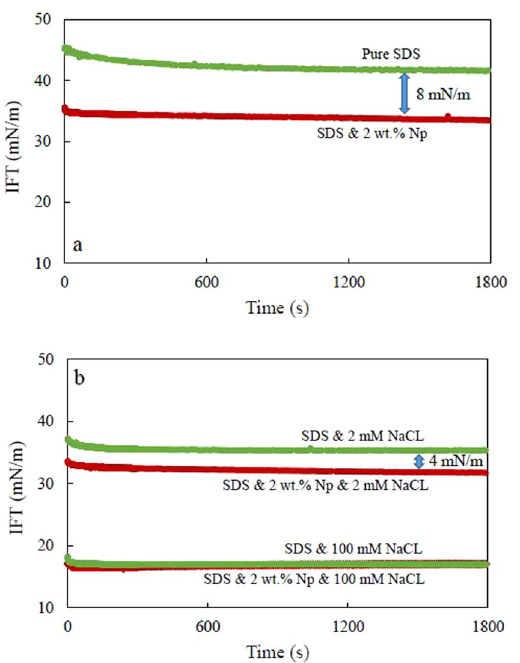
Figure 5. The effect of nanoparticles (Levasil 100/45, 30 nm) on dynamic IFT of heptane/SDS solution ( a ) without salt, ( b ) in the presence of NaCl at concentrations of 2 and 100 mM. In all experiments, the surfactant and nanoparticle concentrations were fixed at 2.9 × 10 − 1 mM (0.035 CMC) and 2 wt.%, respectively. The average error for each experiment is less than 0.5 mN/m.